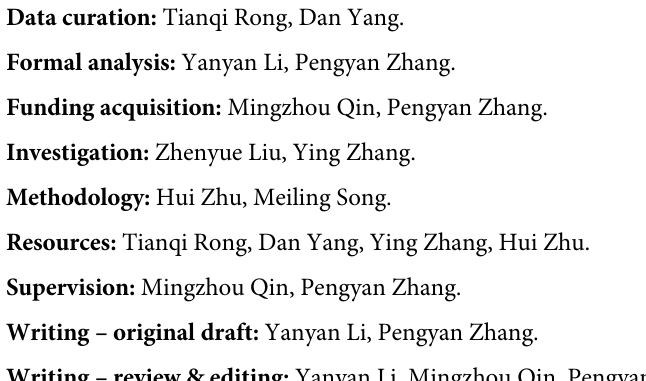
S2 Fig. Distribution of K value in the study area. The scope of the Qin River Basin was deter- mined based on DEM and eight-direction (D8) algorithm. Based on authors’ field investiga- tion, we have modified and adjusted the vector boundary. S3 Fig. Distribution of LS value in the study area. The scope of the Qin River Basin was determined based on DEM and eight-direction (D8) algorithm. Based on authors’ field investi- gation, we have modified and adjusted the vector boundary. S4 Fig. Distribution of C value in the study area from1990 to 2018. The scope of the Qin River Basin was determined based on DEM and eight-direction (D8) algorithm. Based on authors’ field investigation, we have modified and adjusted the vector boundary. S5 Fig. Distribution of P value in the study area from1990 to 2018. The scope of the Qin River Basin was determined based on DEM and eight-direction (D8) algorithm. Based on authors’ field investigation, we have modified and adjusted the vector boundary. S1 Table. The standard for classification and gradation of soil